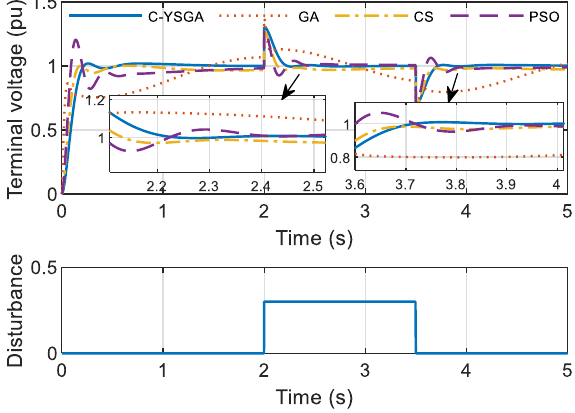
Figure 20. Step responses in the case of measurement noise. Based on the previous figures, it is obvious that the FOPID controller whose parameters are optimized by using a novel C-YSGA algorithm provides a significantly better ability to reject different types of disturbances. Comparison is conducted with some of the most popular and most used algorithms, whose performances, in this case, are remarkably weaker than the proposed method. To be more precise, from Figures 18 and 19, it can be noted that the voltage does not reach its nominal value after the disturbance is introduced, when the controllers presented in [5,10,11] are used. Such fluctuations in the terminal voltage, caused by the inability of the controller to reject the disturbance,